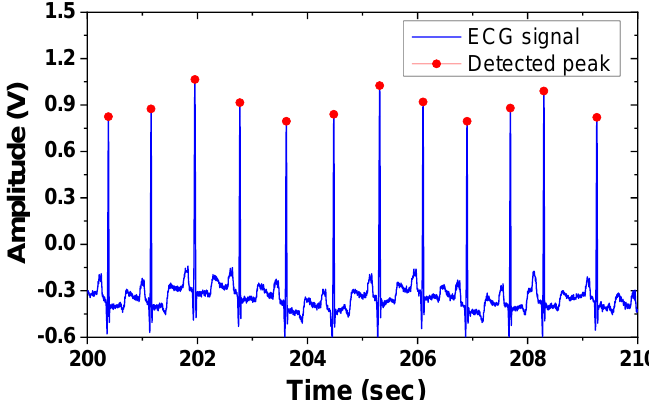
Figure 28. Flowchart of the ECG peak detection algorithm.